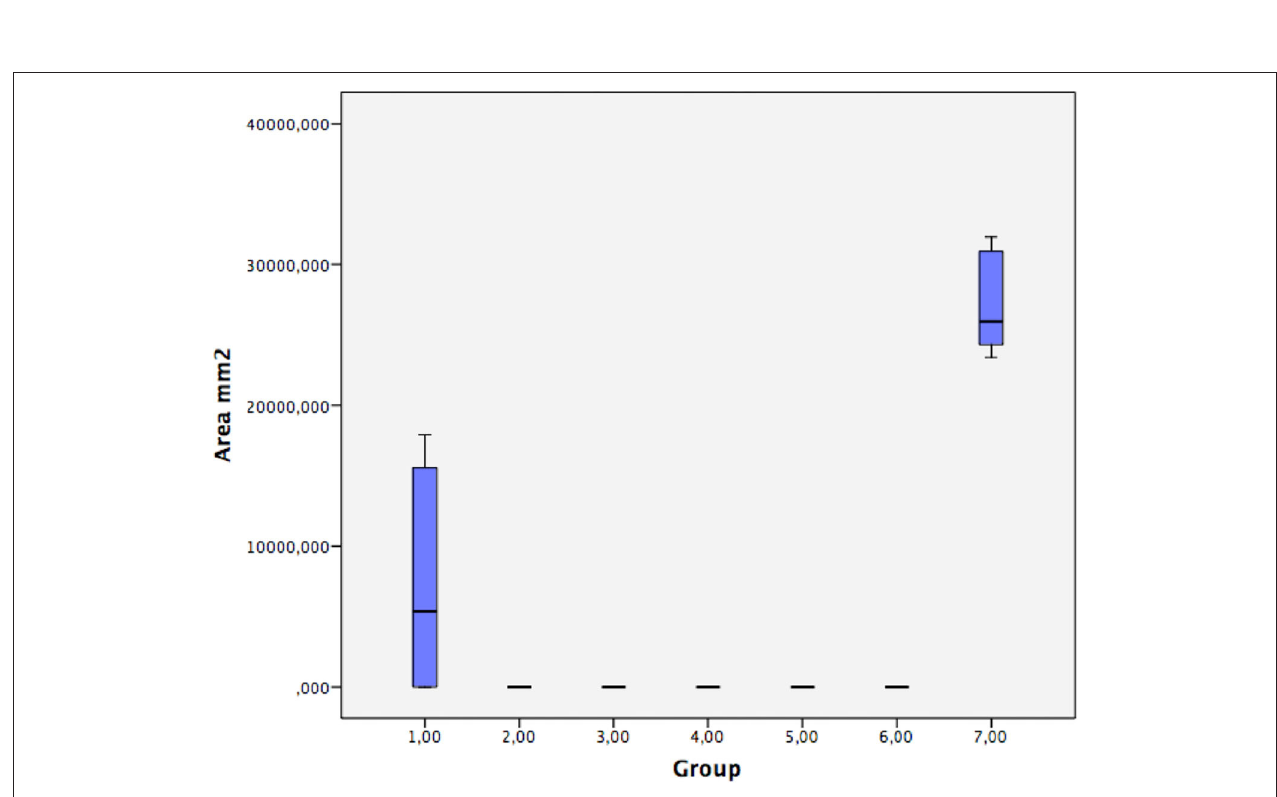
FIGURE 3 | Distribution of pigmented areas for all